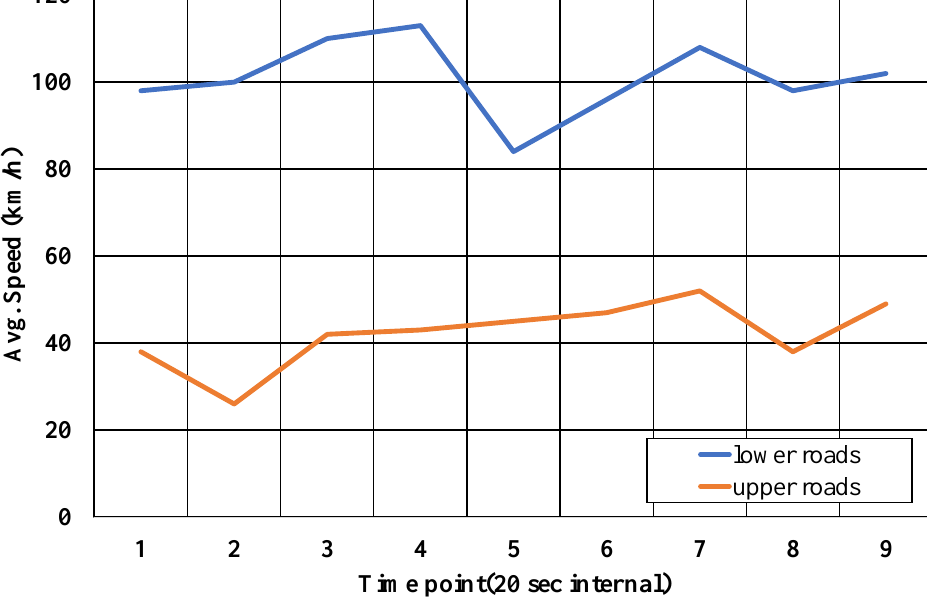
Figure 10. Speed estimation